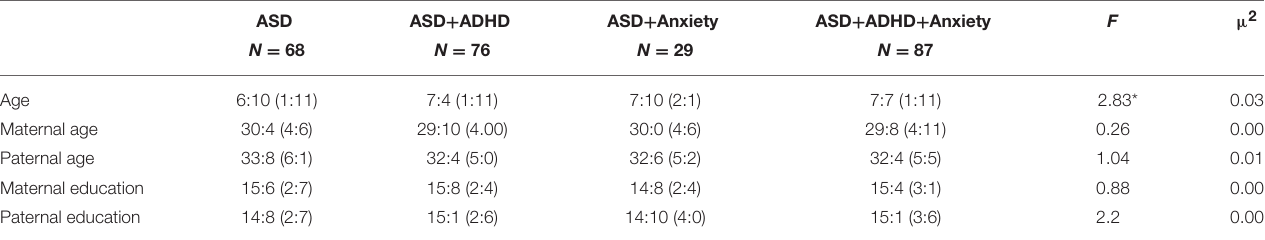
TABLE 2 | Mean scores and standard deviation of demographic variables in the ASD alone, ASD + ADHD, ASD + anxiety, and ASD + ADHD + anxiety groups.